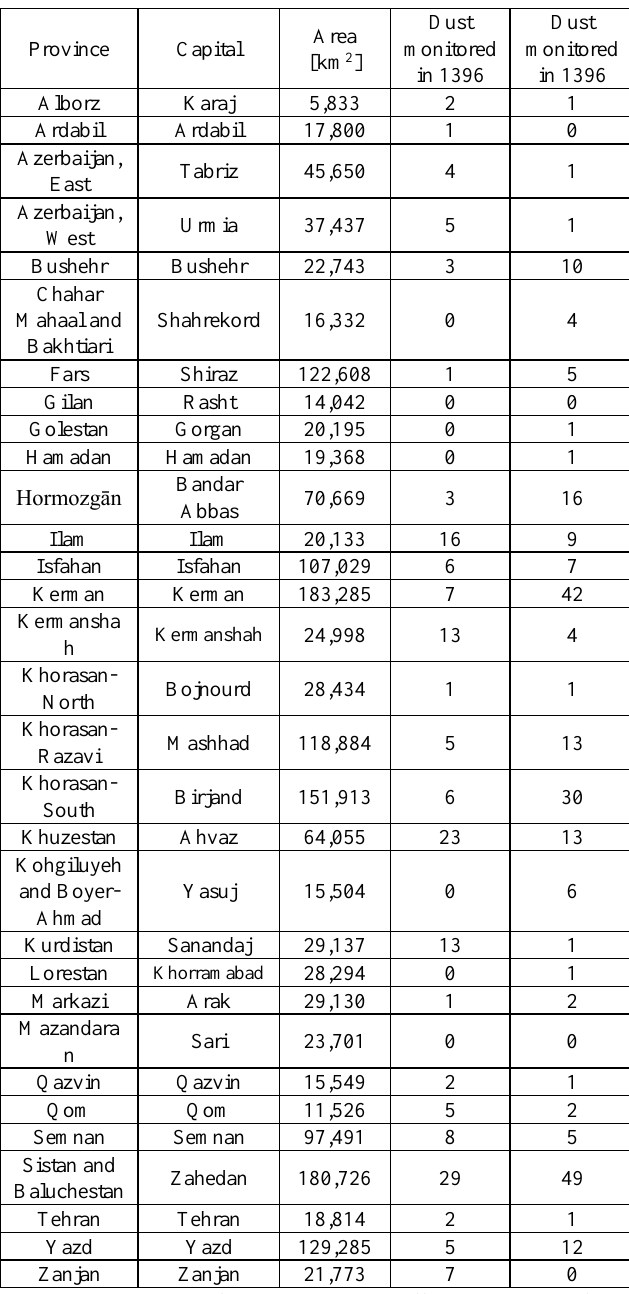
Table 1. The number of dust monitored in different provinces